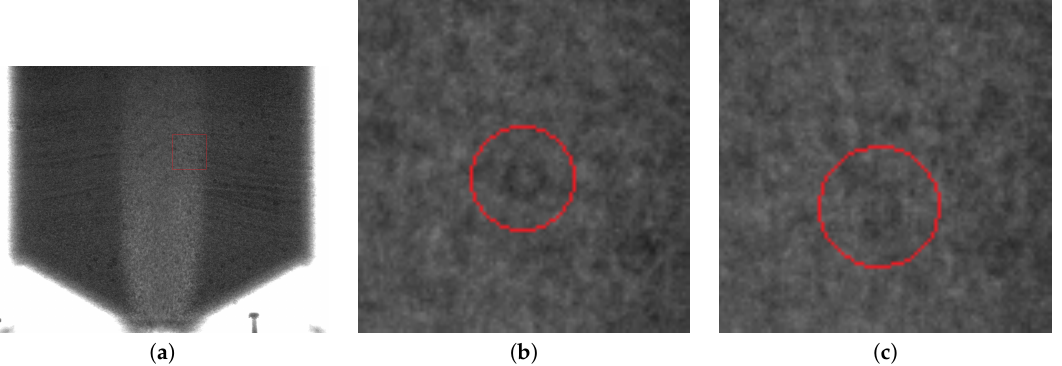
Figure 3. Difficulty of distinguishing markers in radiography images: ( a ) frame with the investigated area marked, ( b ) zoomed-in marker, and ( c ) the same marker on the next